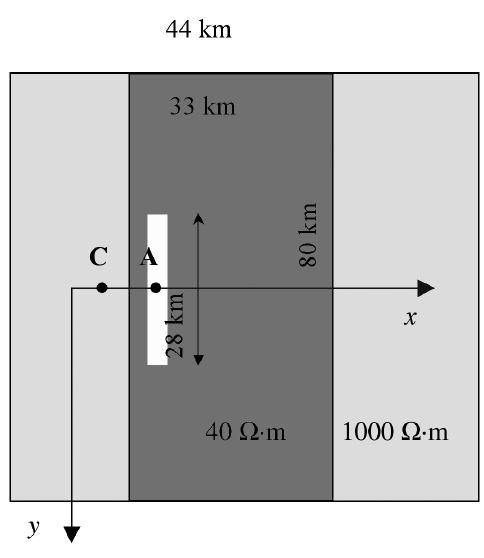
Fig. 3. 3D resistivity model (plane